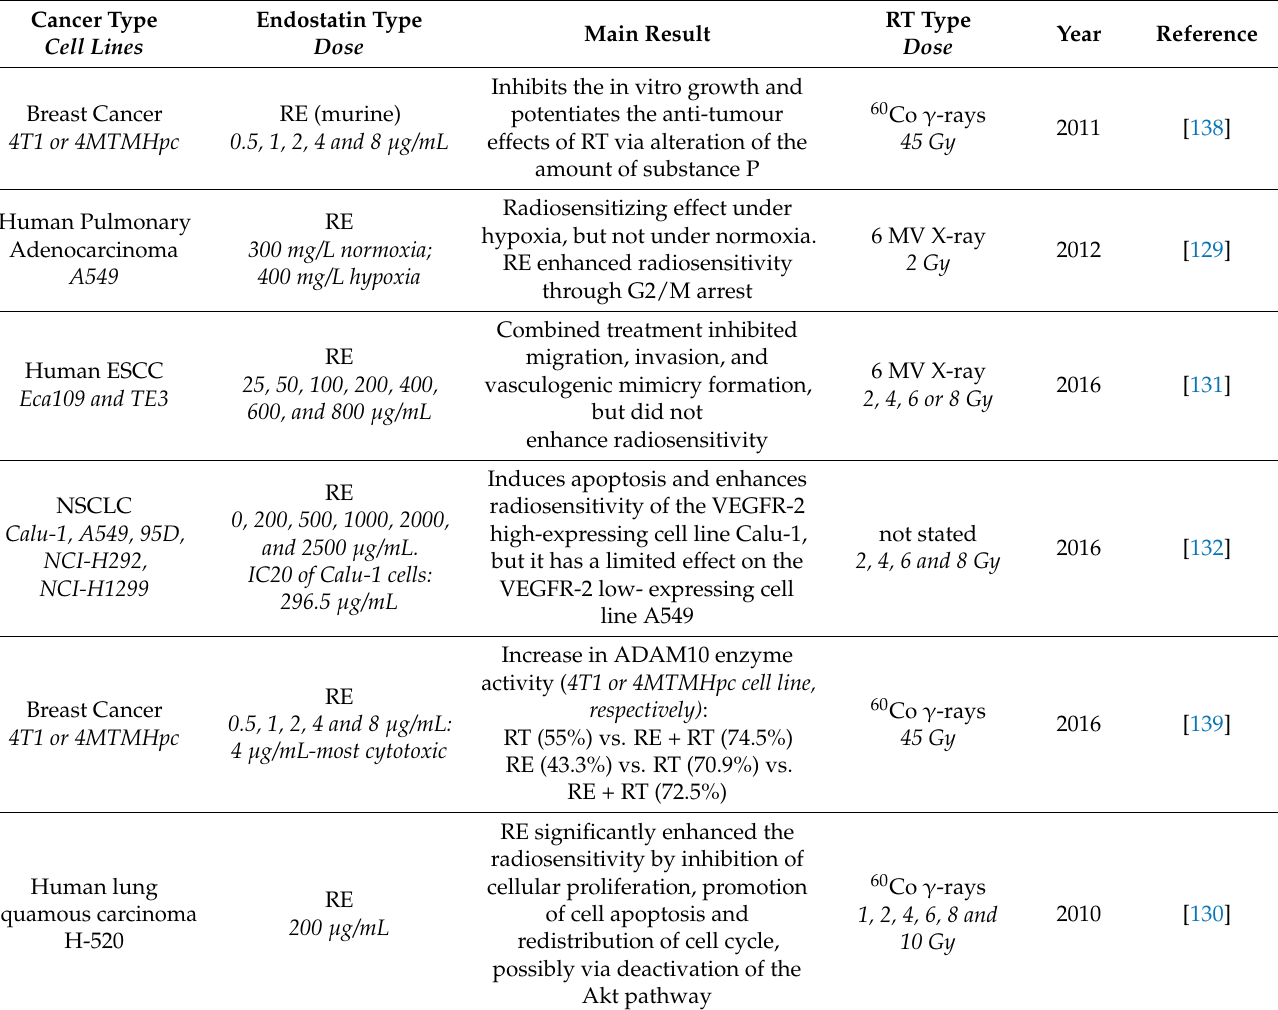
Table 1. Summary of in vitro studies on RE combined with